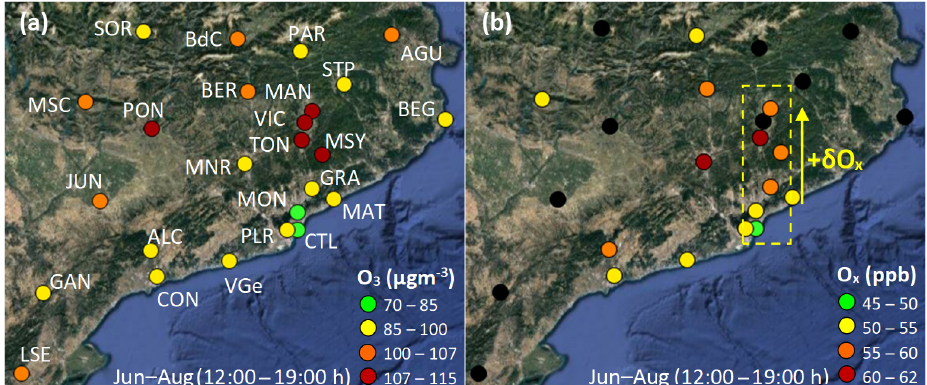
Figure 3. Spatial variability of mean June–August O 3 (a) and O x (b) concentrations from 12:00 to 19:00LT observed in selected air quality monitoring sites. Data from Ciutadella (CTL), Palau Reial (PLR), Montcada (MON), Granollers (GRA), Montseny (MSY), Tona (TON), Vic (VIC), Manlleu (MAN), Pardines (PAR), Montsec (MSC), Begur (BEG), Bellver de Cerdanya (BdC), Berga (BER), Agullana (AGU), Santa Pau (STP), Mataró (MAT), Manresa (MNR), Ponts (PON), Sort (SOR), Juneda (JUN), La Sénia (LSE), Constantí (CON), Gandesa (GAN), Vilanova i la Geltrú (VGe) and Alcover (ALC) air quality monitoring